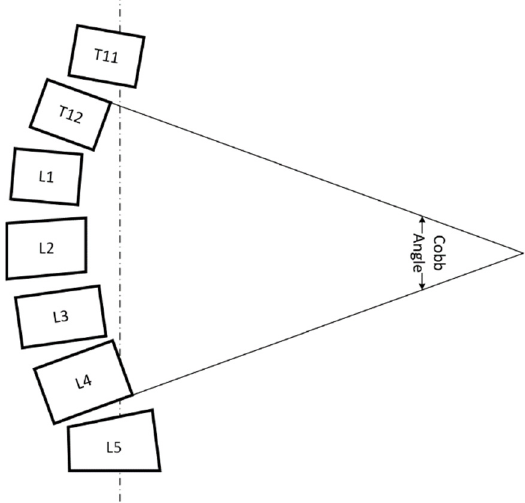
Figure 1. Schematic of Cobb angle measurements: the Cobb angle is defined as the angle between the extension line of the upper end plate of the most inclined vertebral body in a curved segment and the extension line of the lower end plate of the most inclined vertebral body below.